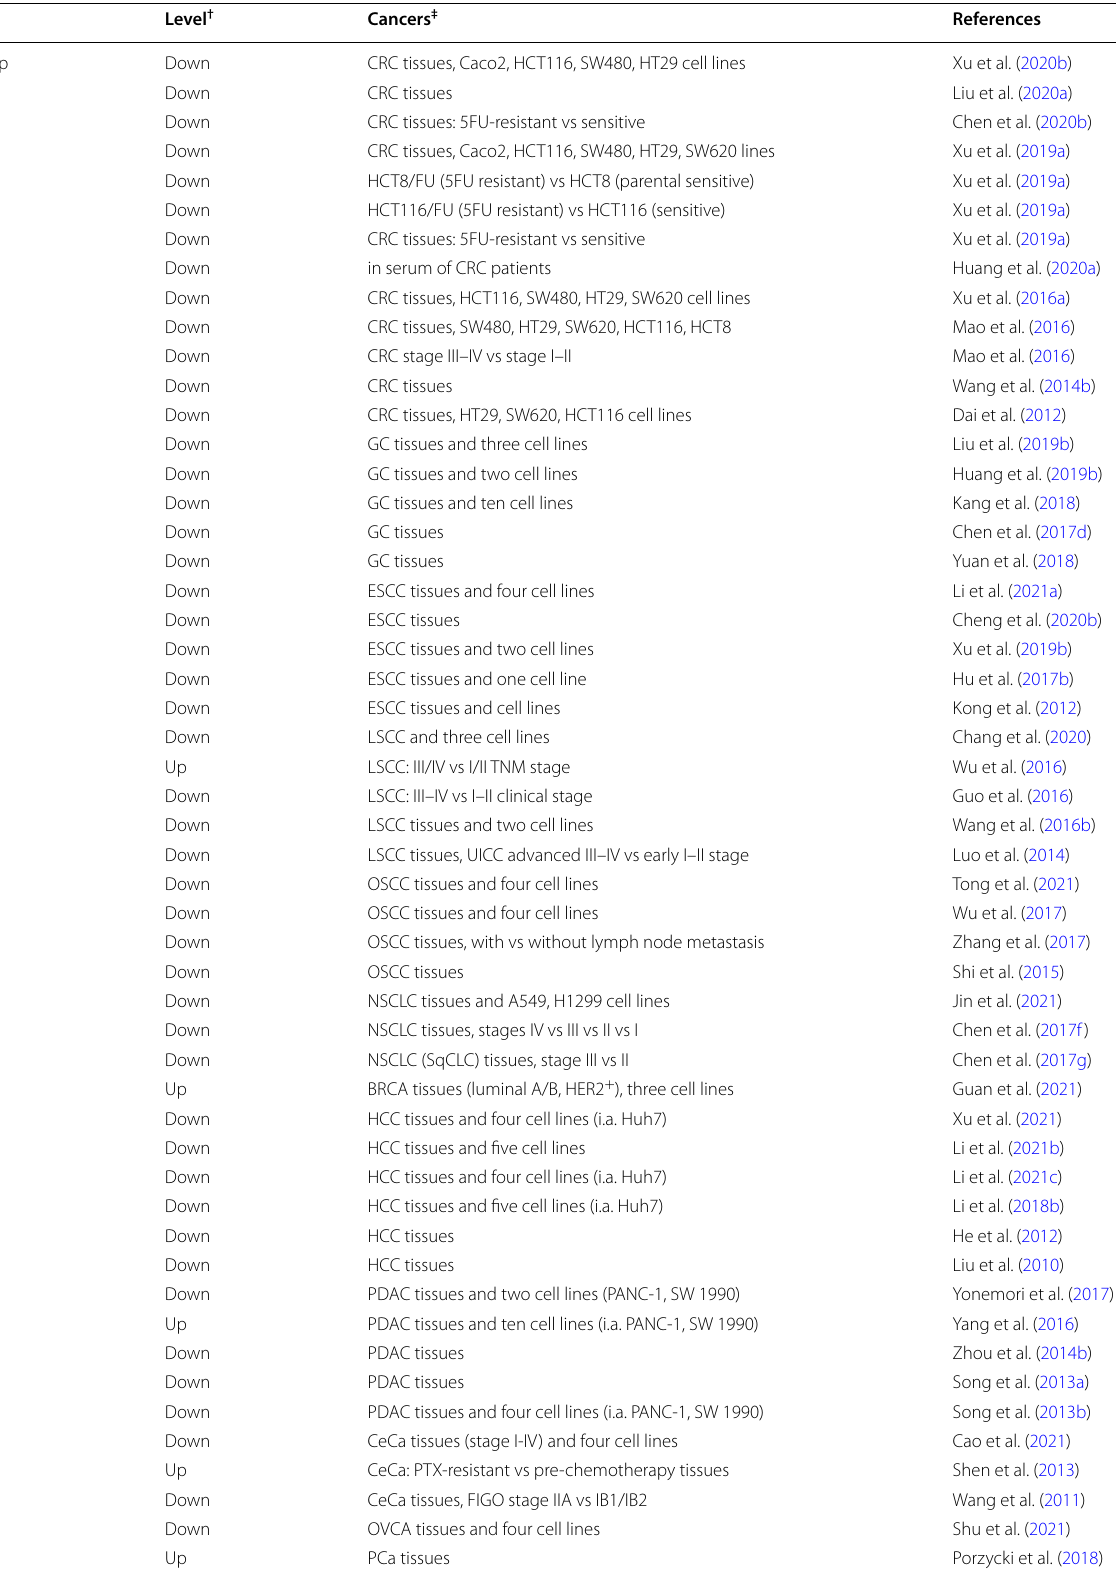
Table 12 Expression levels of miRNAs targeting i.a. T YMS mRNA in cancer